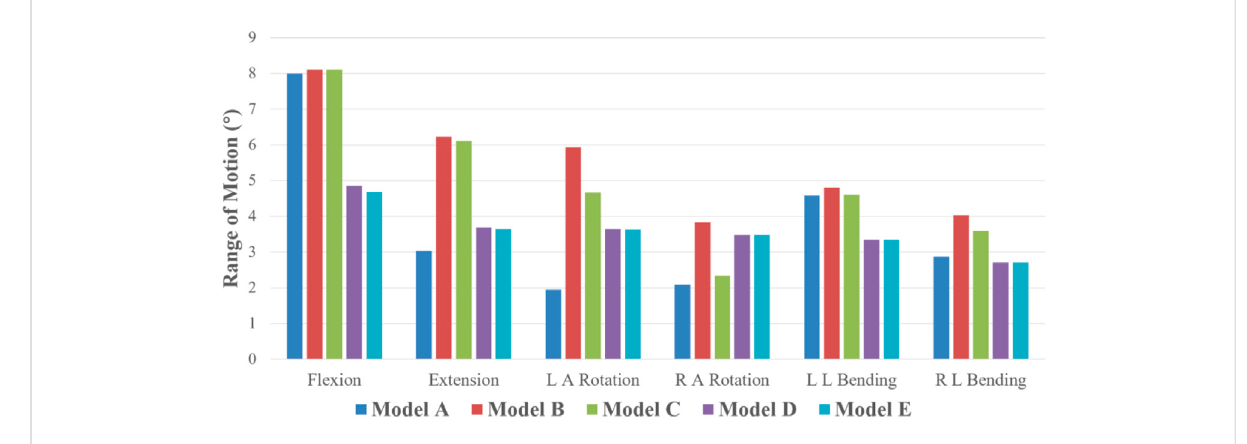
FIGURE 4 ROM of fi ve fi nite element models under six motion states.